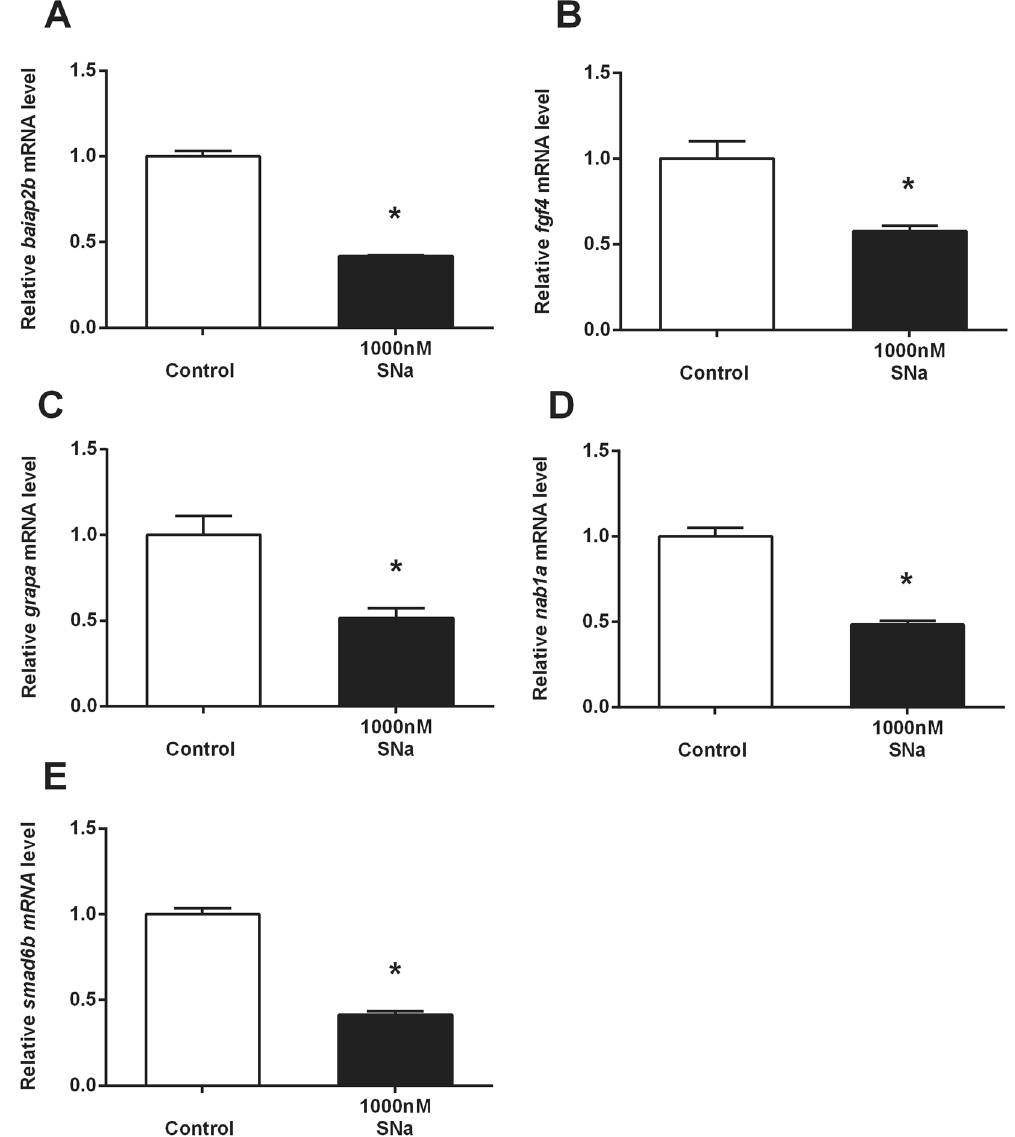
Figure 3. Quantitative real-time PCR analysis for ( A ) baiap2b , ( B ) fgf4 , ( C ) grapa , ( D ) nab1a and ( E ) smad6b mRNA in Carassius auratus RGC culture exposed to 1000 nM SNa. Data were normalized and defined as fold- change relative to control. Bars represent the mean + SEM (n = 4). Treatment groups marked by asterisks have significantly different mRNA levels compared to control (P <